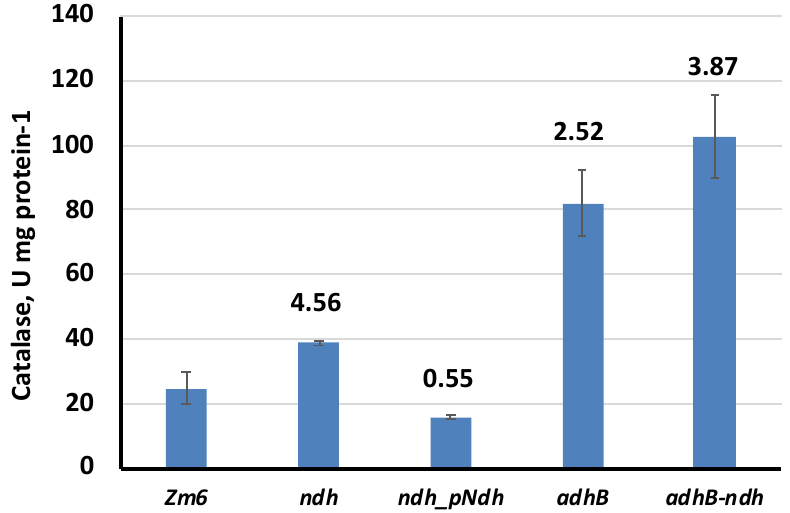
Figure 4. Catalase activity and cat gene expression in the mutant strains. Mean data from three experiments are presented. For all mutant strains, catalase activity significantly differs ( p < 0.01) from that of Zm6. The numbers above the bars show the log 2 fold change of cat transcription in the mutants (log 2 (mutant/Zm6)), and represent the mean values of two RT-qPCR experiments, each with two technical repeats.